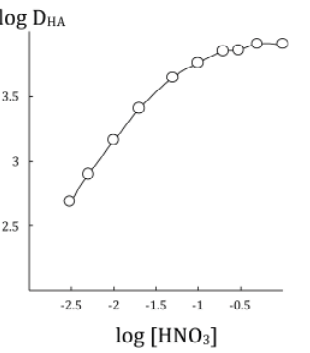
Figure 1. Influence of HNO concentration in the aqueous phase 3 on the distribution of D2EHPA between the FB-D2EHPA sorbent and the aqueous phase. CHA = 1.0 mmol g -1 . The sizes of the points represent error bars.